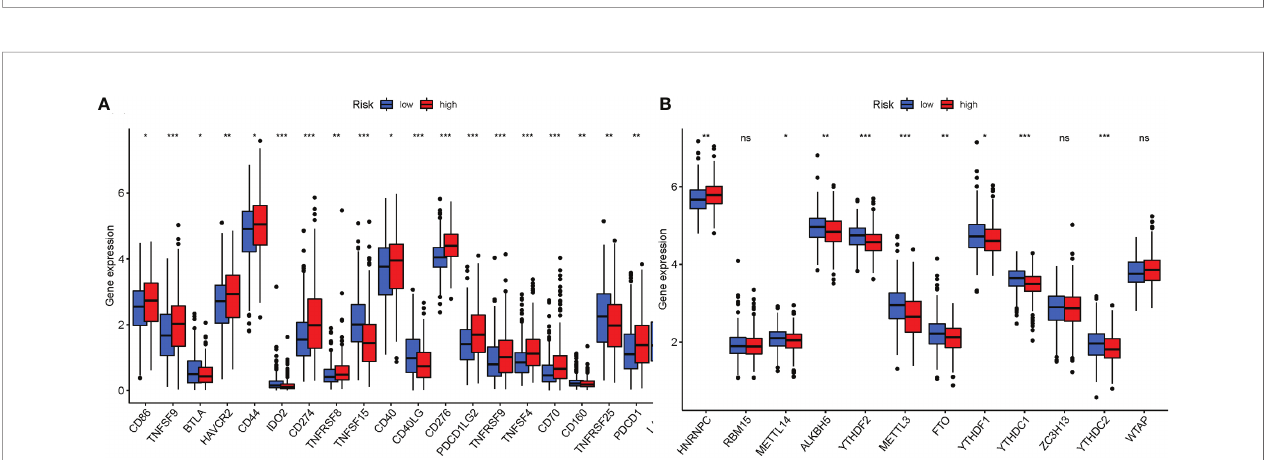
FIGURE 11 | (A) Expression of immune checkpoints among high and low LUAD risk groups. (B) The expression of m 6 a-related genes between high and low LUAD risk groups. P values were shown as ns, not signi fi cant; *P < 0.05; **P < 0.01; ***P < 0.001.